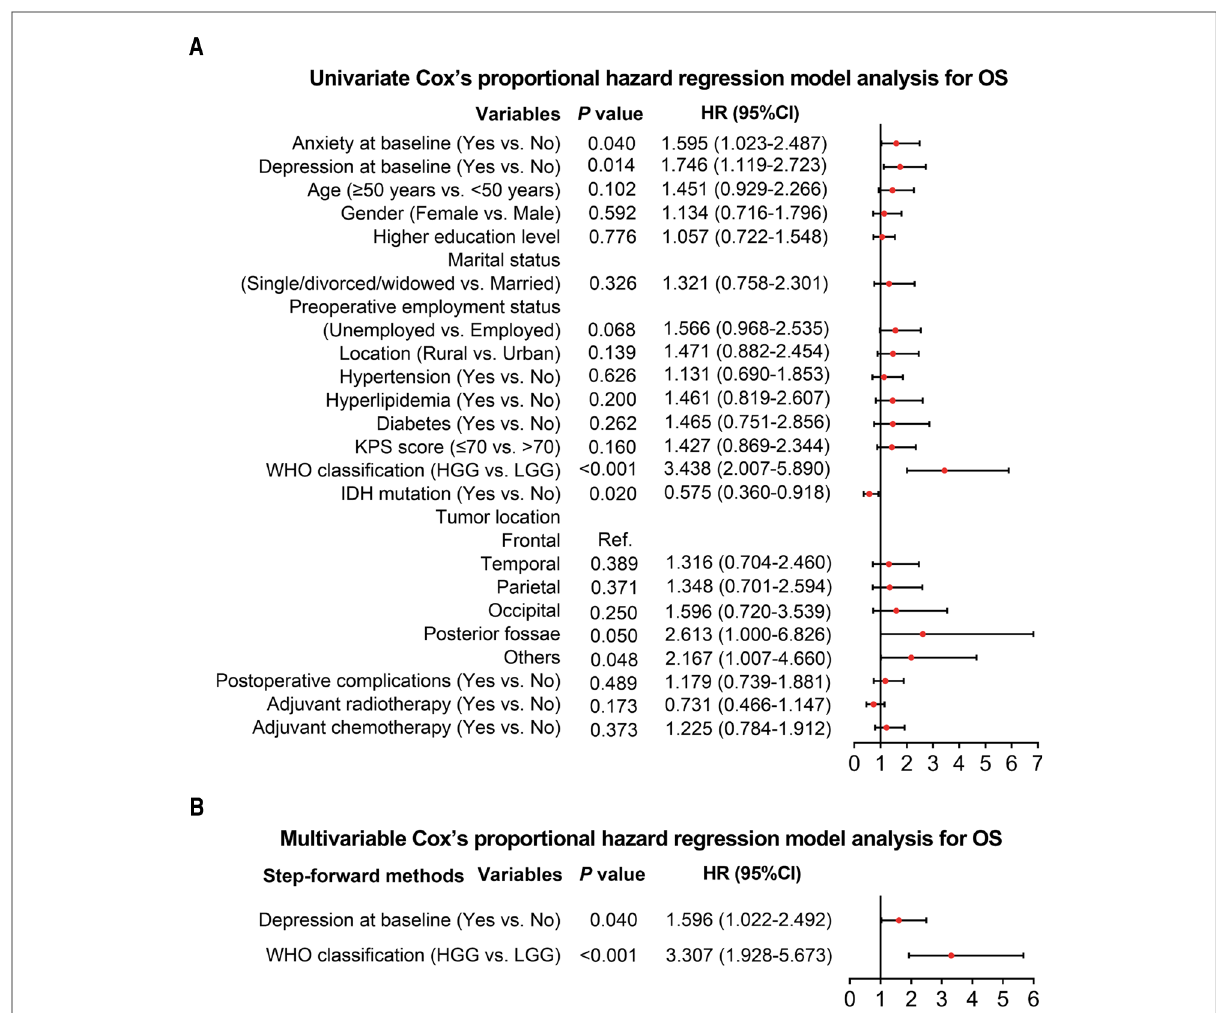
FIGURE 3 Cox ’ s proportional hazard regression for factors in fl uencing OS in glioma patients. Factors related to OS in glioma patients by univariate Cox ’ s proportional hazard regression ( A ). Independent factors that affect OS in glioma patients by multivariate Cox ’ s proportional hazard regression ( B